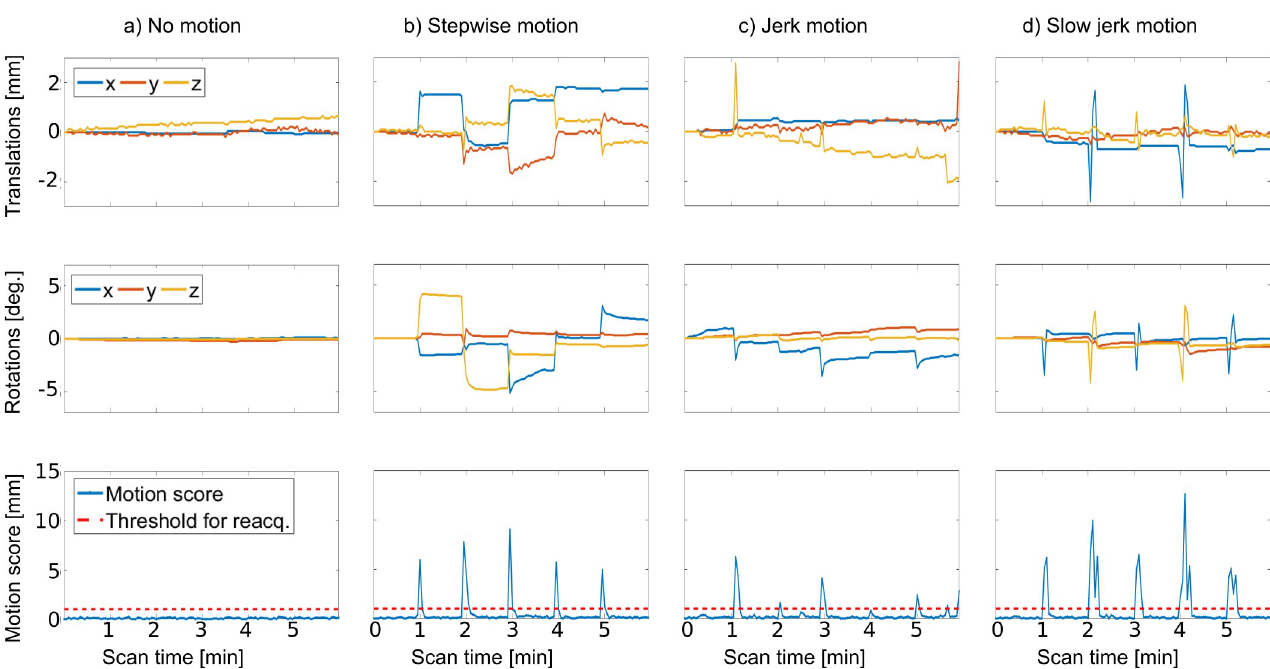
Fig 6. Examples of position parameters obtained from the navigators in the T1 sequence, for the different motion scenarios. The translations and rotations shown are the accumulated motion updates performed, and thus reflect the patient position relative to the starting position. The motion score reflects the change in position between every navigator and leads to reacquisition of the previously acquired k-space segment in the T1 sequence when above 1 mm.